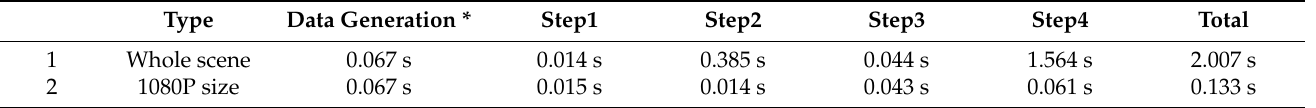
Table 2. Comparison of timeliness between the whole scene and the 1080p size.